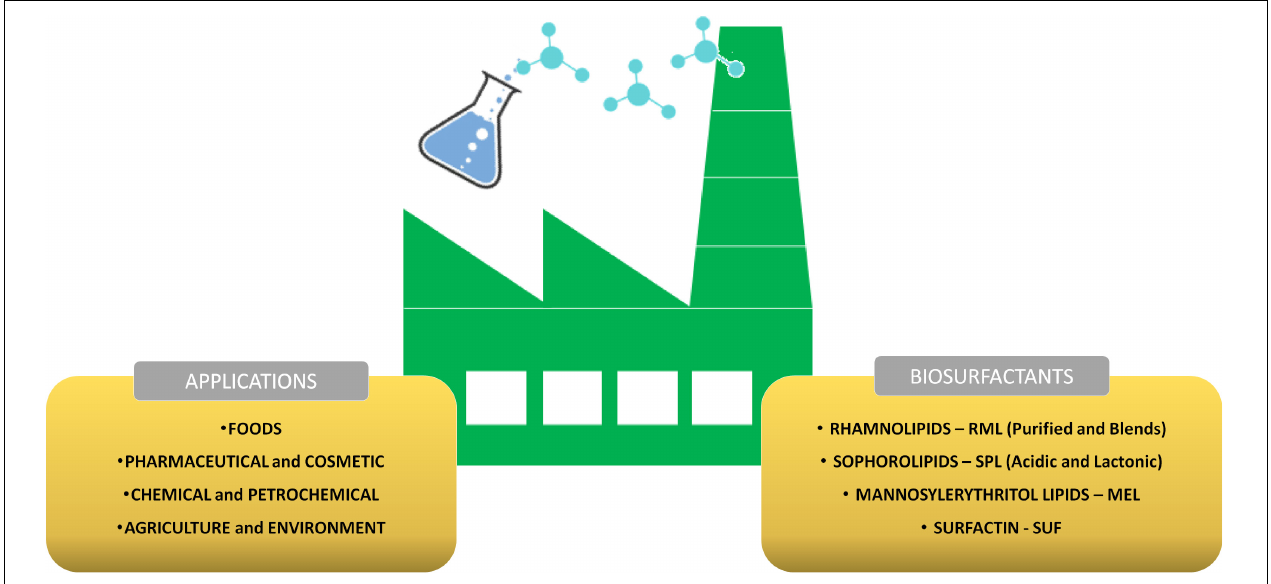
FIGURE 3 | Main BS-producing companies in the world and their applications. BS,